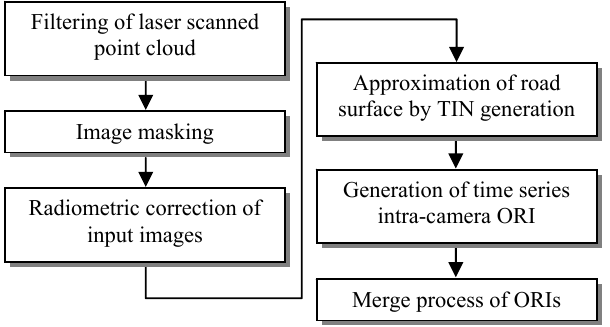
Figure 2. Process flow of ORI